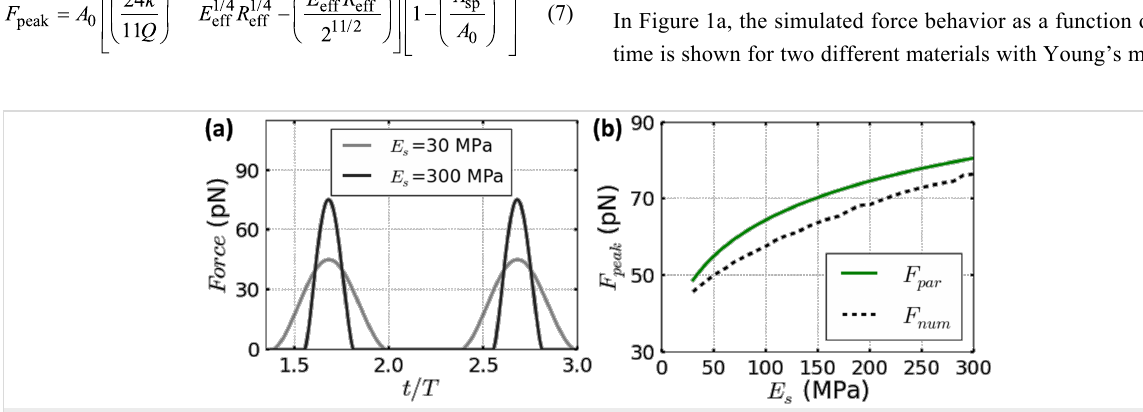
Figure 1: (a) The dependence of the forces on the normalized time for two different Young moduli 30 MPa (light gray line) and 300 MPa (dark gray line). (b) The dependence of the peak forces on the sample Young modulus for the parametrical equation of Equation 8 (full line plots) and the corre- sponding numerical simulations for Tatara’s contact mechanics (dashed line plots). Parameters defined for (a) and (b) are: A 0 = 1 nm, A sp = 0.9 A 0 , Q = 2, k = 0.1 N/m and R t = 5